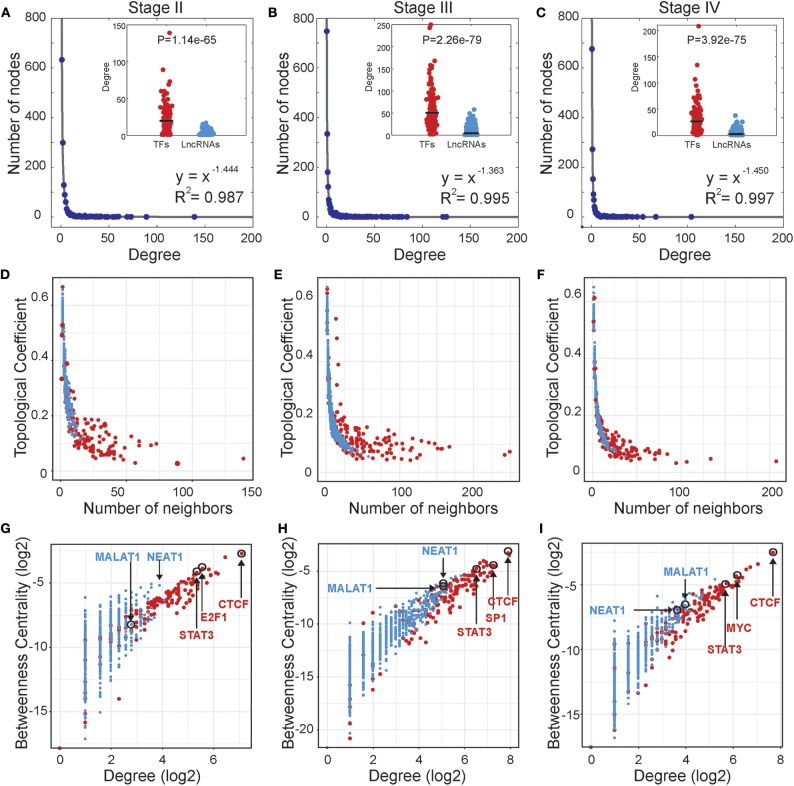
Topological properties of stage-specific TF-lncRNA regulatory networks. (A–C) The degree distributions of nodes in the three networks. The TF nodes have significantly higher degree values than lncRNA nodes in each stage. (D–F) The topological coefficients decreased with the increase in number of neighbors. (G–I) Some well-known OC risk TFs and lncRNAs can be found in the TF-lncRNA networks and exhibit higher values of betweenness centrality and degree.